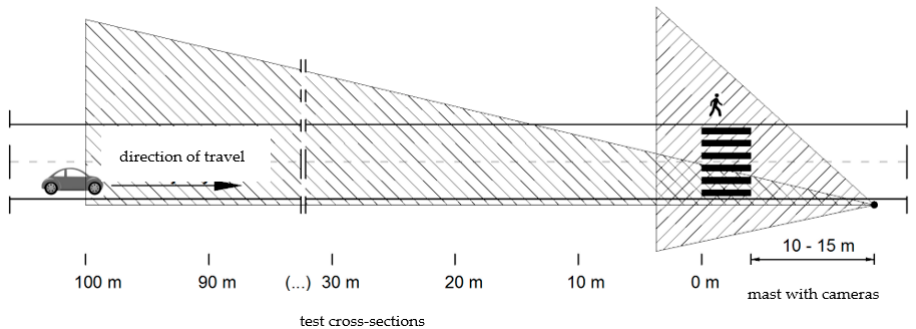
Figure 2. Diagram of field tests using video recording instruments.